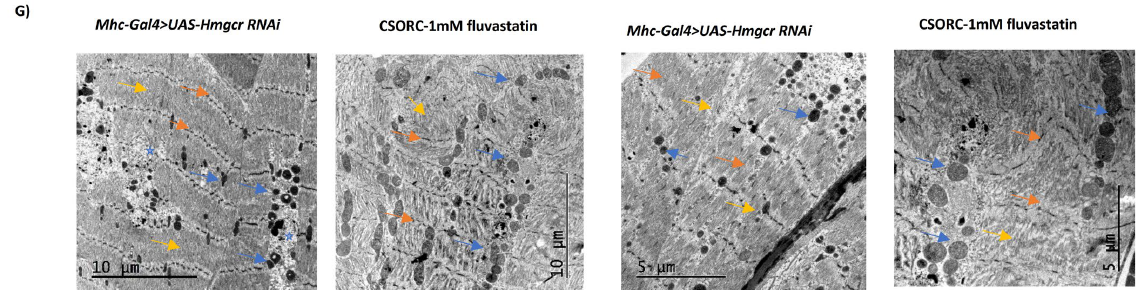
Figure 4. Hmgcr knockdown on skeletal muscles results in reduced locomotion activity and mitochon- drial phenotypic changes. Hmgcr knockdown was carried out by using the Gal4-UAS system, where Hmgcr RNAi knockdown group is Mhc-Gal4>UAS-Hmgcr RNAi and control groups are Mhc-Gal4>w1118 and w1118>UAS-Hmgcr RNAi . Male flies, aged 1-2 days after eclosion and fed with normal food, were collected for experiments. ( A ) The histograms show the general locomotion activity (activity counts/30 min and total activity) and activity while awake using DAMs and the number of flies is indicated in the brackets. ( B1 – B3 ) The left histograms indicate the average moves, speed and positions for a total six-hour interval while the right show the same per hour for flies using the force climbing locomotion system and the number of flies is indicated in the brackets. ( C ) TEM micro- graphs for the morphology of the longitudinal section of leg skeletal muscles show normal sarco- mere (orange arrow) architecture and myofibrils and Z-line (yellow arrow) along with more capa- cious vacuoles (black arrow) in Hmgcr RNAi knockdown flies comparable to both controls. The mito- chondria (blue arrows) are more ring-shaped and severely fragmented in Hmgcr RNAi knockdown flies. ( D ) Using ImageJ software, the sarcomere length, in µM, was measured in TEM micrographs (indicated in brackets) in each group. ( E ) Using ImageJ software, we traced the mitochondria area in TEM micrographs. The histogram represents the area of mitochondria in µm 2 where the dots represent the number of mitochondria. ( F )Using ImageJ software, we counted the number of round- like shaped mitochondria in TEM micrographs where the dots represent the total number of mito- chondria in each TEM micrograph. ( G ) TEM micrographs for the morphology of longitudinal sec- tions of leg skeletal muscles for Hmgcr RNAi knockdown flies and CSORC flies treated with 1 mM fluvastatin for five days. Each bar represents the mean value (±SEM). For B 1, 2 and 3, two-way ANOVA with Bonferroni’s multiple comparisons was used. For ( A , D – F ), first, the Shapiro–Wilk test was used to check normality; accordingly, the statistical difference was calculated using one- way ANOVA with Bonferroni’s multiple comparisons for normally distributed data and Kruskal– Wallis one-way tests for otherwise data whereby * p ≤ 0.05; ** p ≤ 0.01; *** p ≤ 0.005; **** p ≤ 0.0001.